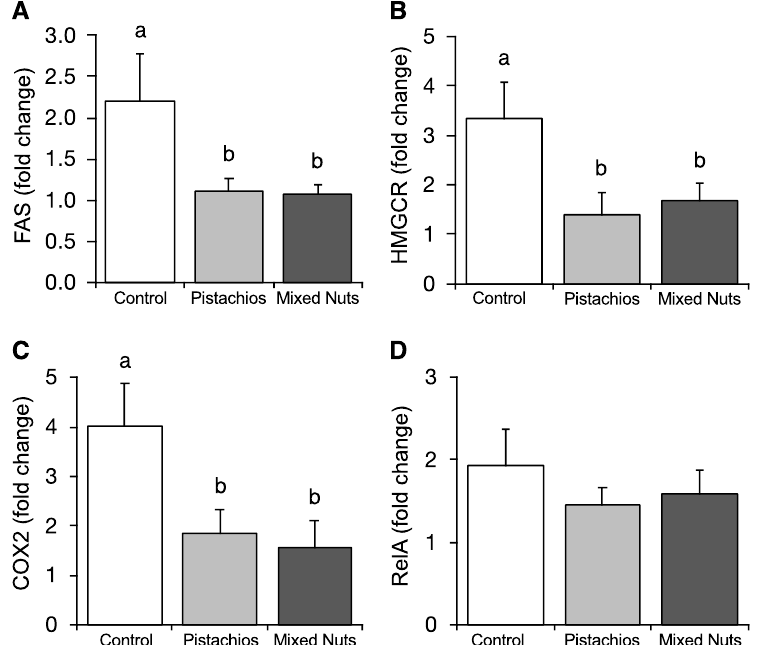
Figure 4. Effects of pistachios and mixed nuts on ( A ) FAS, ( B ) HMGCR, ( C ) COX2, and ( D ) RelA. Bars represent means ± SE (standard error). Bars with different superscripts differ significantly at p < 0.05. FAS, fatty acid synthase; HMGCR, 3-hydroxy-3-methylglutaryl-CoA reductase; COX2, cyclooxygenase 2; RelA, nuclear factor NF-kappa-B p65 subunit.